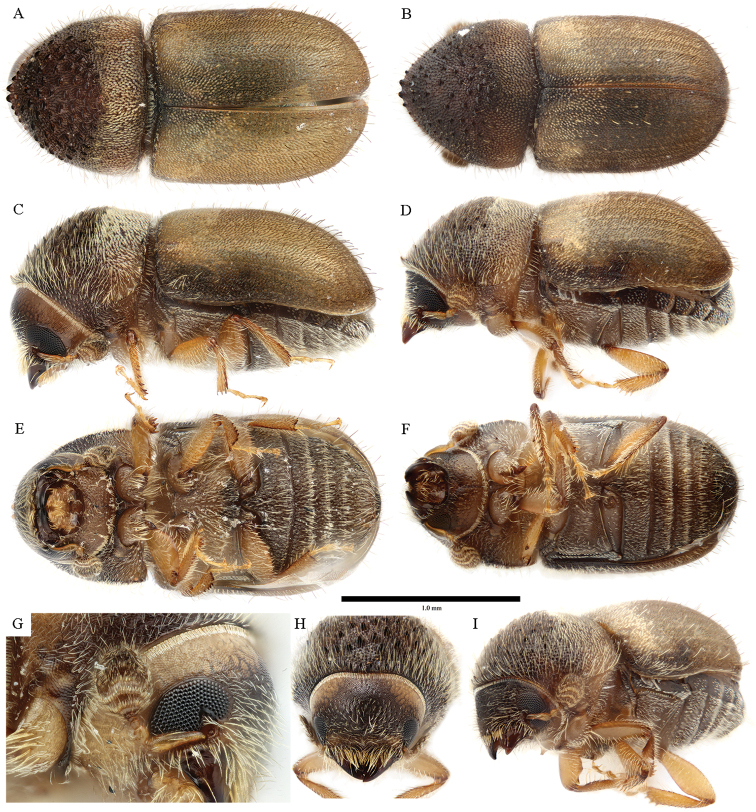
Cryphalus
dilutusA, C, E, G, H female, UFFE:33200 B, D, F, I male, UFFE:34684.